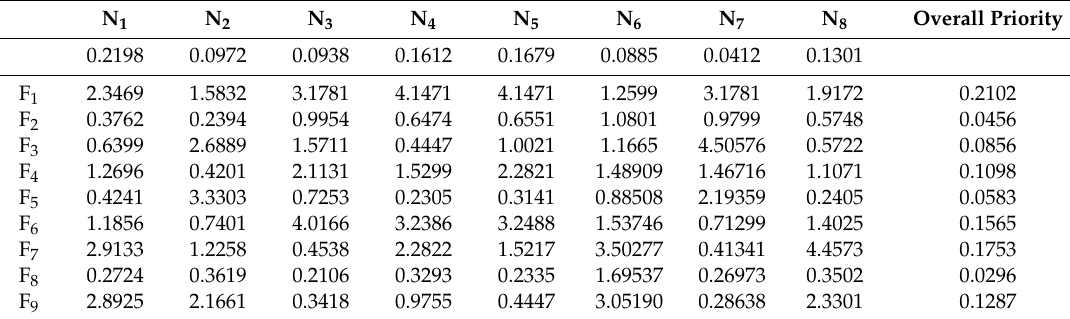
Table 11. The overall design features priority sequence